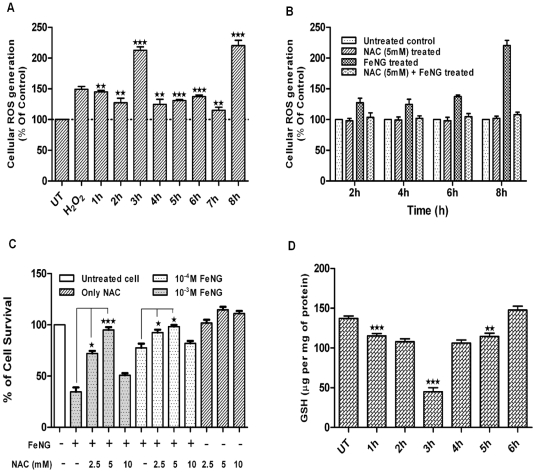
Reactive oxygen species (ROS) plays an important role in FeNG induced apoptosis.(A) CEM/ADR5000 cells were either kept untreated or treated with FeNG (10−4 M) and intra cellular ROS generation was measured [in terms of peroxide using dichlorofluorescein diacetate (DCF-DA)] as described under
Materials and Methods
 at different time points. Data are expressed as percent of control and are presented as mean±SD of 3 independent experiments. Differences between control and FeNG treated cells are significant *P<0.05, **P<0.01, ***P<0.001, by unpaired Student's t test. (B) NAC completely abrogated FeNG induced ROS generation in CEM/ADR5000 cells. Cells were either kept untreated or pretreated with NAC (5 mM) for 1 h. Then the cells were further cultured for 2 h, 4 h, 6 h and 8 h in the presence or absence of FeNG (10−4 M) and intra cellular ROS generation was measured. (C) Represents that NAC protects CEM/ADR5000 cells from FeNG induced cell death. CEM/ADR5000 cells were either left untreated or pretreated with different concentration of NAC for 1 h. The cells were then treated with FeNG (10−3 M or10−4 M) for 72 h and cell death was monitored by MTT assay. Value represents the mean ± SD of three independent experiments with four replicates in each. Significant difference at *P<0.05, ***P<0.001, respectively, from only FeNG treated cells. (D) FeNG depletes intra cellular glutathion (GSH) contents of CEM/ADR5000 cells. Cells were either kept untreated or treated with FeNG (10−4 M) for indicated time points and intra cellular GSH was measured as described under
Materials and Methods
. Results are presented as mean±SD of 3 independent experiments. Differences between untreated control and FeNG treated cells are significant **P<0.01, ***P<0.001, by unpaired Student's t test.